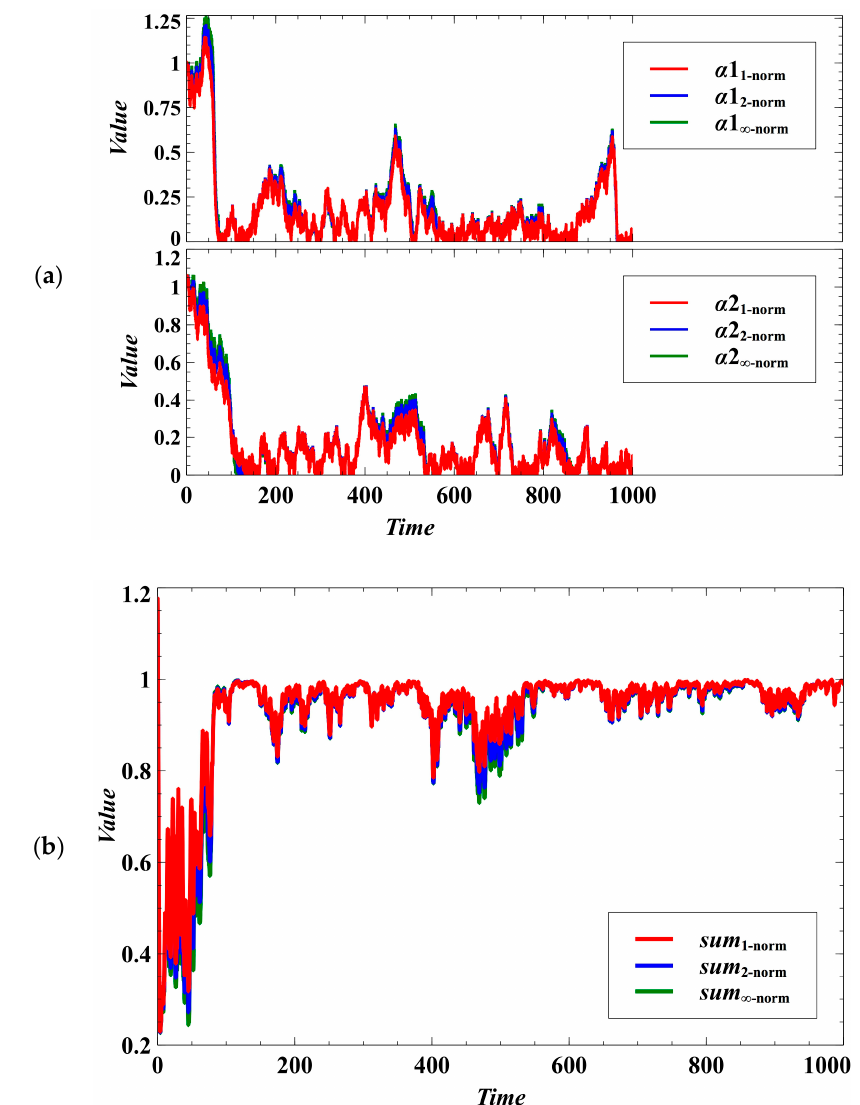
Figure 5. Effect of using different norms in the evolutionary objective under the stochastic case. The distinctive characteristics of the outcomes under the Manhattan, Euclidean, and Chebyshev norms become homogeneous. ( a ) Effect on lowering the parasitism exploitation coefficient. ( b ) The sums represent the carrying capacity of the environment where species 1 and 2 compete for the available resources. The desired goal is to maximize the utilization of the resources (sum equals 1).